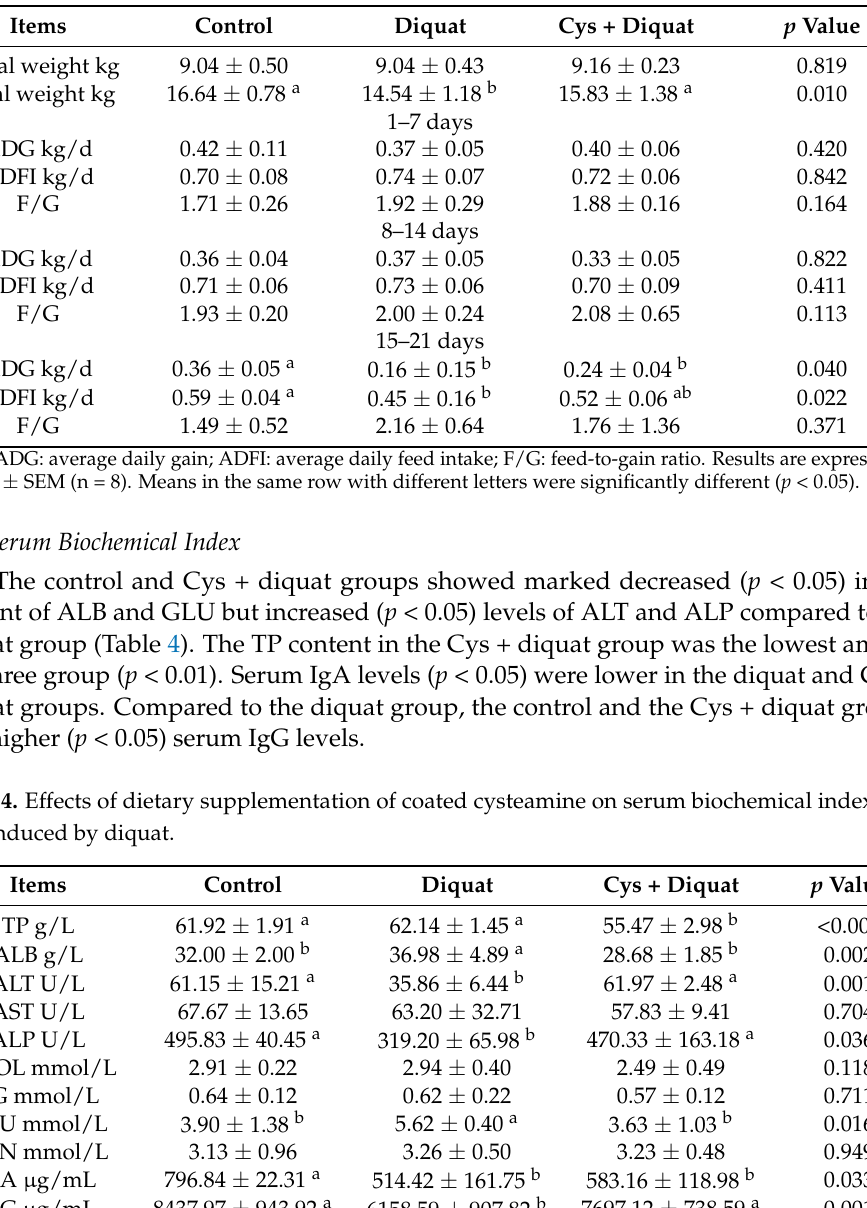
Table 3. Effects of dietary supplementation of coated cysteamine on growth performance of pigs induced by diquat.